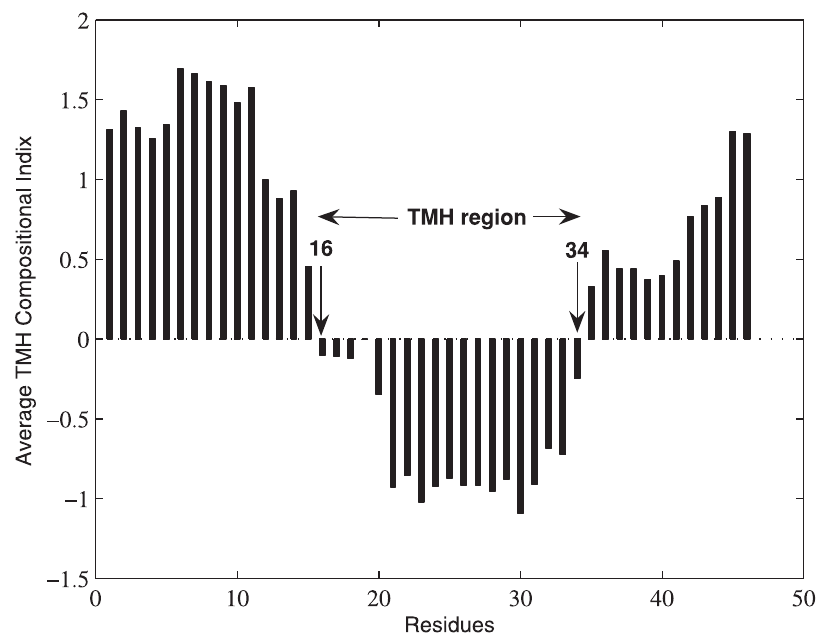
Figure 6. TMH segment detection in protein 1OCC using the compositional index r i .